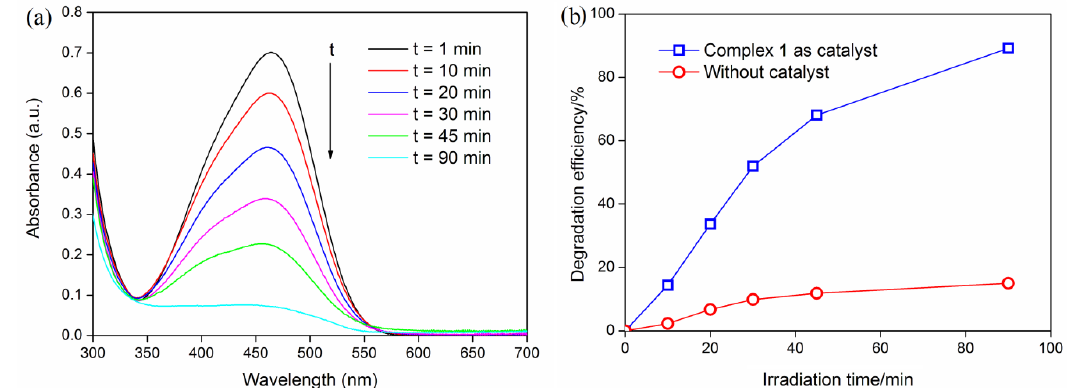
Figure 4. ( a ) The UV-Vis absorption spectra of methyl orange (MO) solution during the decomposition reaction under UV irradiation; ( b ) Degradation efficiencies of MO under UV light.